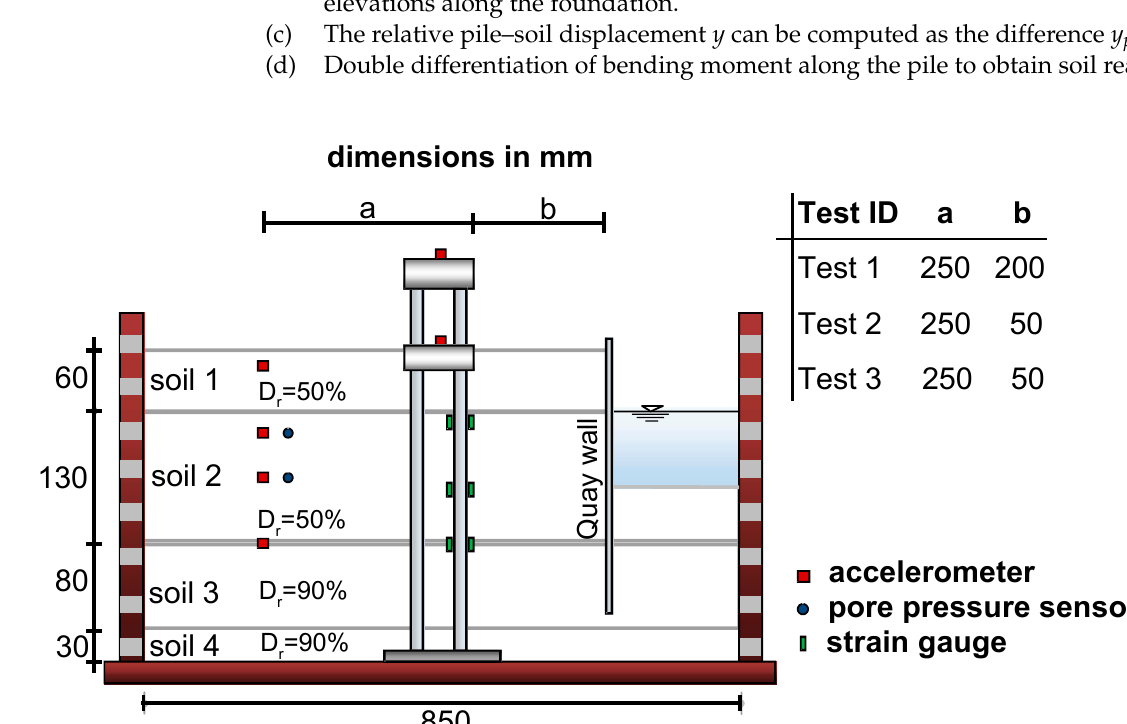
Figure 42. Test setup and instrumental layout used in centrifuge tests.